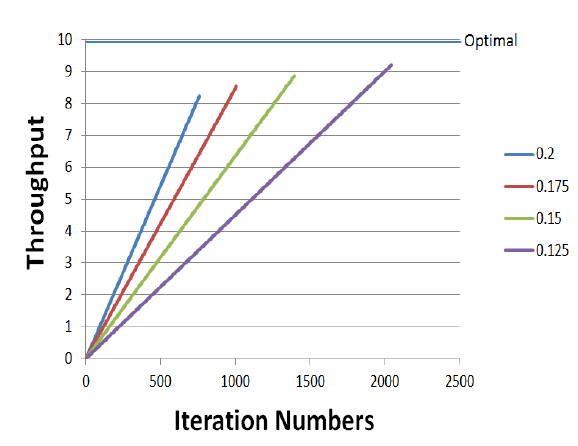
Figure 6. Throughput v.s.  with 20 nodes ( k =4)